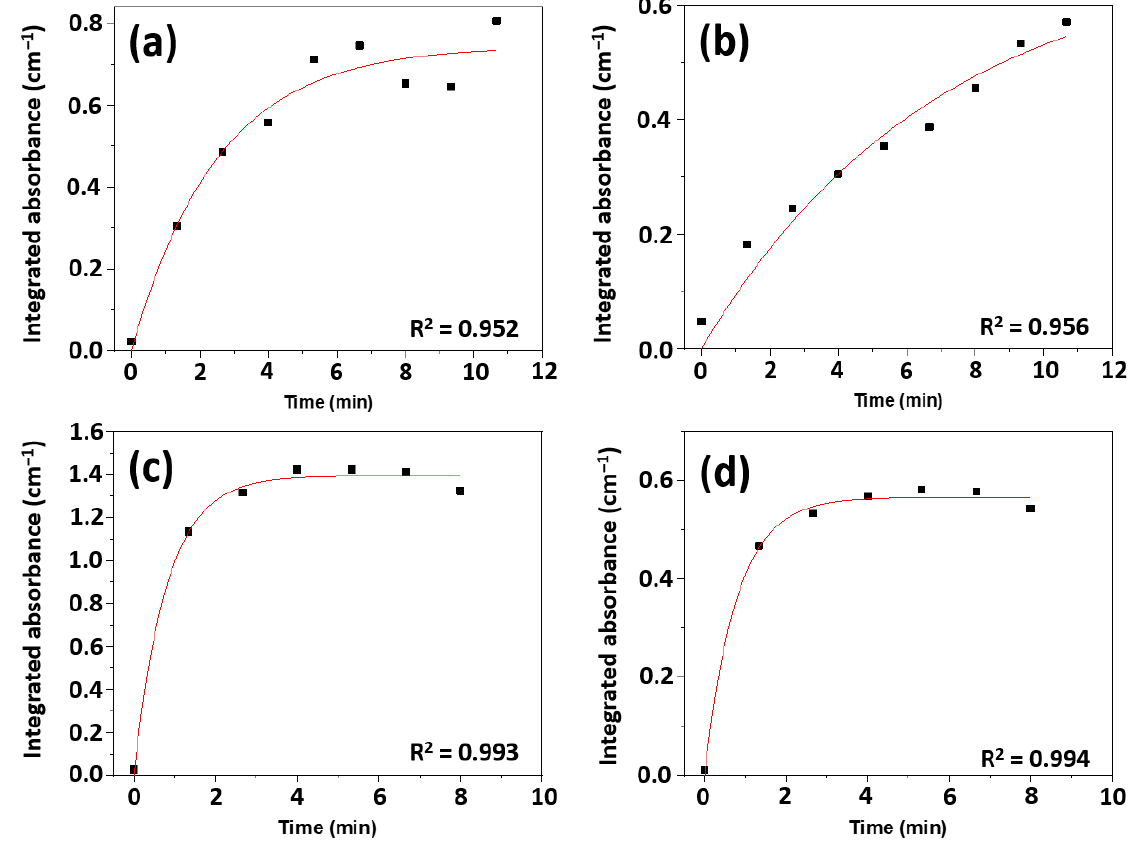
Figure 7. Integrated absorbance (black squares) for the build-up of aldehydes during UV illumination for ( a ) UV100_TMP (1700 cm −1 – 1835 cm −1 ), ( b ) UV100_TEP (1700 cm −1 – 1815 cm −1 ), ( c ) Ti-600_TMP (1700 cm −1 – 1850 cm −1 ), and ( d ) Ti-600_TEP (1700 cm −1 – 1820 cm −1 ). Data points were taken every 80 s for a total of 8 min for Ti-600 and ~ 11 min for UV100. The red lines are first-order fittings for y = a(1 − e ( − bx) ), where b is the rate constant.